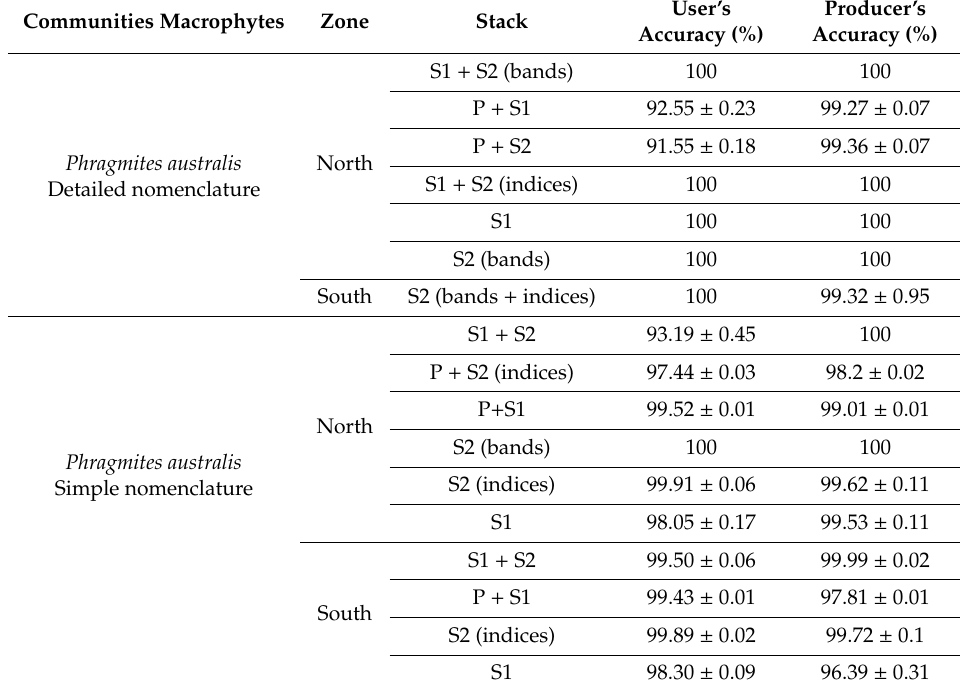
Table 5. The best results of the producer’s accuracy, user’s accuracy and standard errors by species of